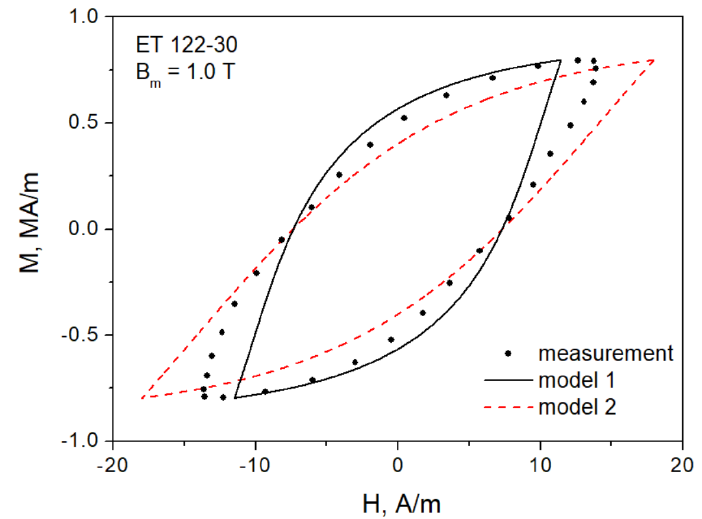
Figure 11. The measured and the modeled minor loop for 𝜇 0 𝑀 m ≅ 1.0 T.